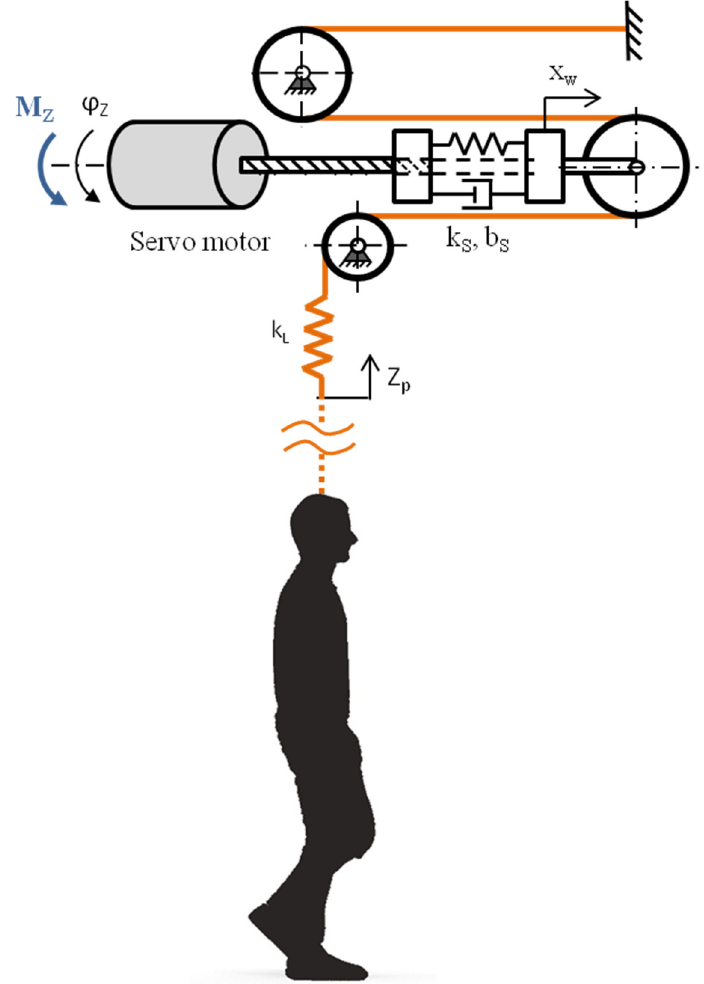
Figure 4. Physical model of the body weight support system.